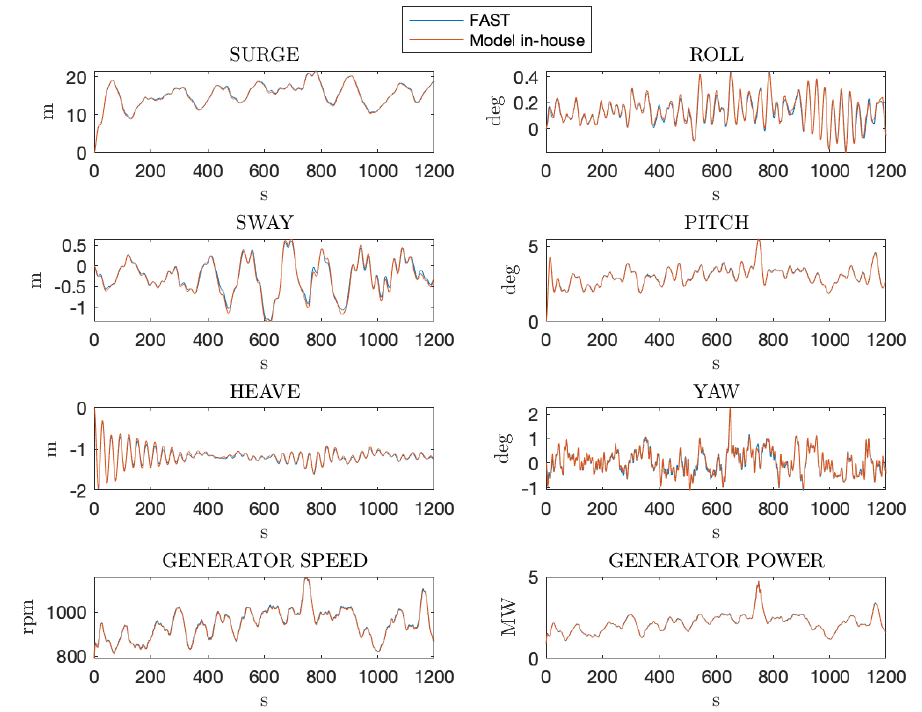
Figure 14. Positions and performances comparison with H s = 0.75 m, T p = 5.5 s, V 0 = 8.5 m/s.